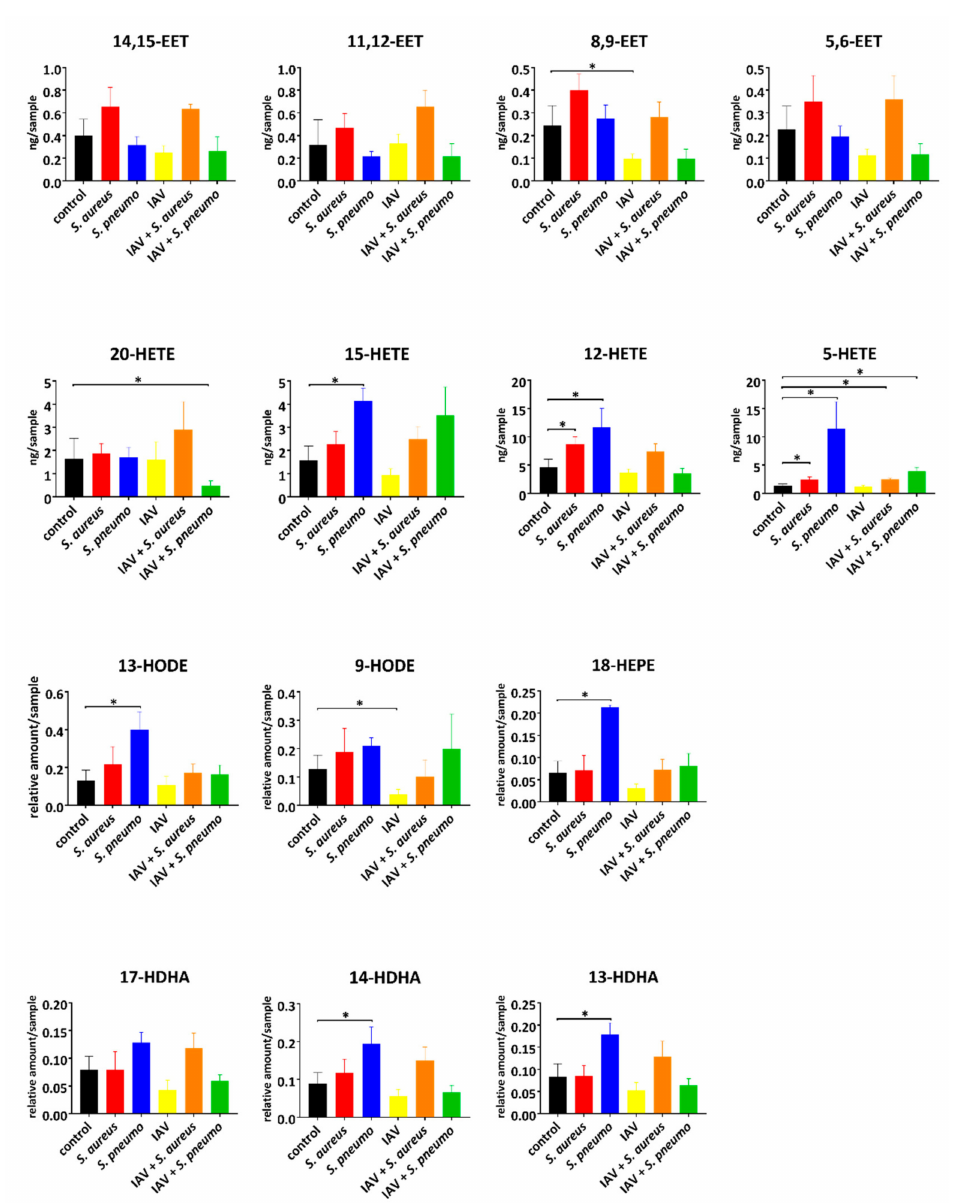
Figure 1. Intracellular lipid mediator amounts in response to indicated bacterial and viral infections: S. aureus LUG2012 (red), S. pneumoniae TIGR4 (blue), IAV rH1N1 (yellow), uninfected control (black) and the co-infections IAV / S. aureus (orange), as well as IAV / S. pneumoniae (green). The bars denote mean values ± standard deviations. For statistical analysis, the Mann–Whitney U-test was used for n = 15 (controls) and n = 4 (infections). The p -values were compared to a significance level α of 0.05 corrected for multiple comparisons using Bonferroni correction for 9 clusters of oxylipins and 5 comparisons resulting from infection conditions. Asterisks indicate significant